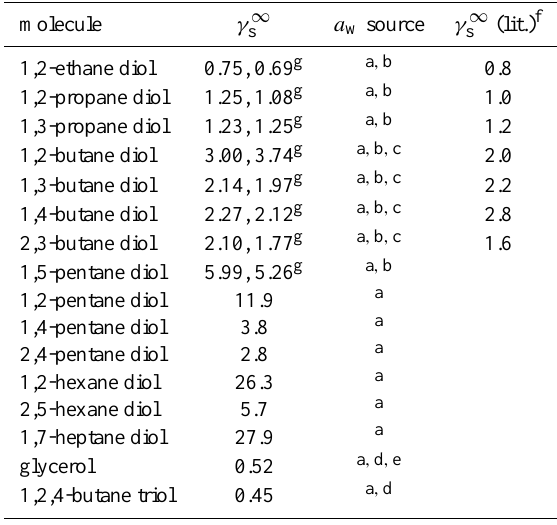
Table 2. Infinite dilution activity coefficients derived in this work, the sources of water activity they are based on, and comparison with the literature. molecule γ ∞